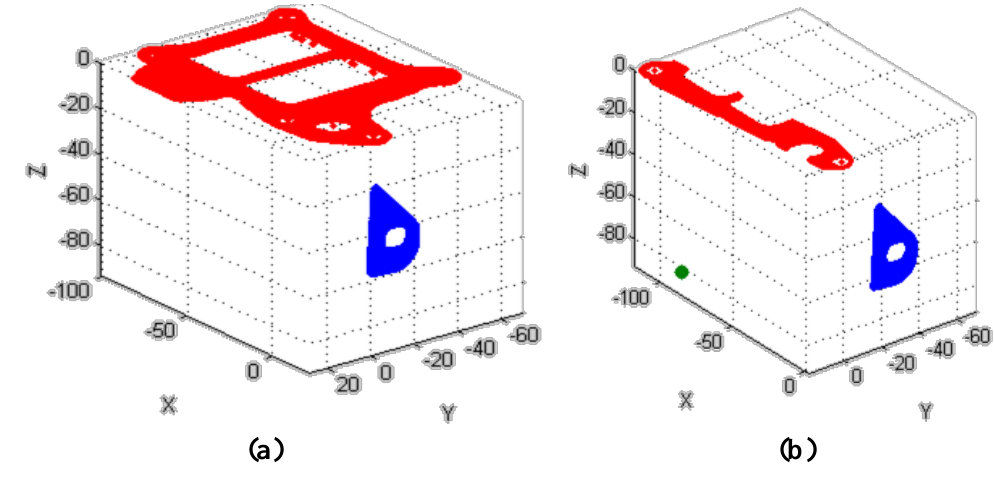
Figure 17. Reconstruction of the scanned cloud points in the global frame of the